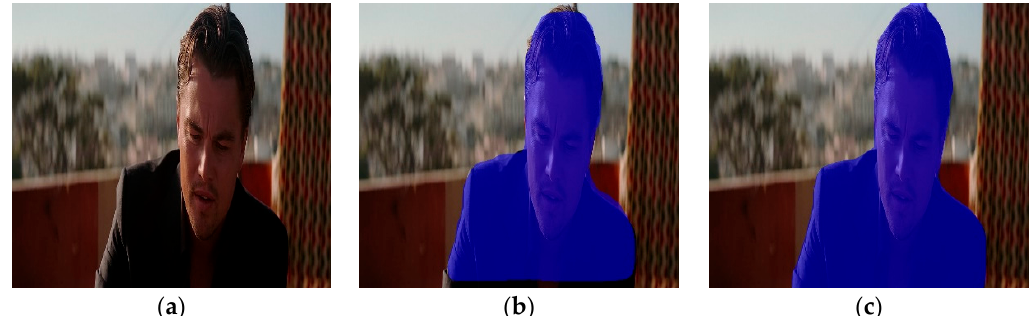
Figure 9. Regular frame examples of semantic segmentation applications: ( a ) Non-mask; ( b ) Mask R-CNN; ( c ) Yolact.